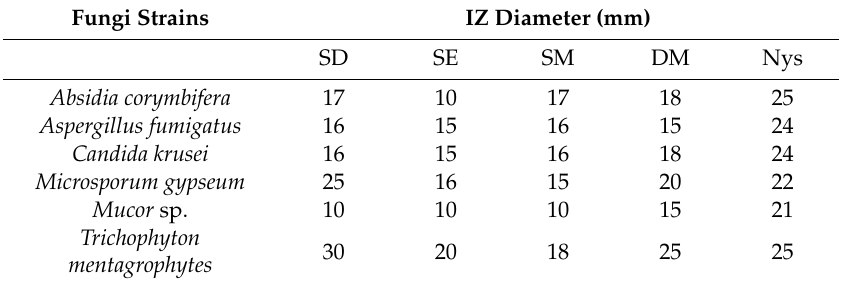
Table 3. Antifungal activity of the root bark extracts of Euclea divinorum in an agar di ff usion test. Fungi Strains